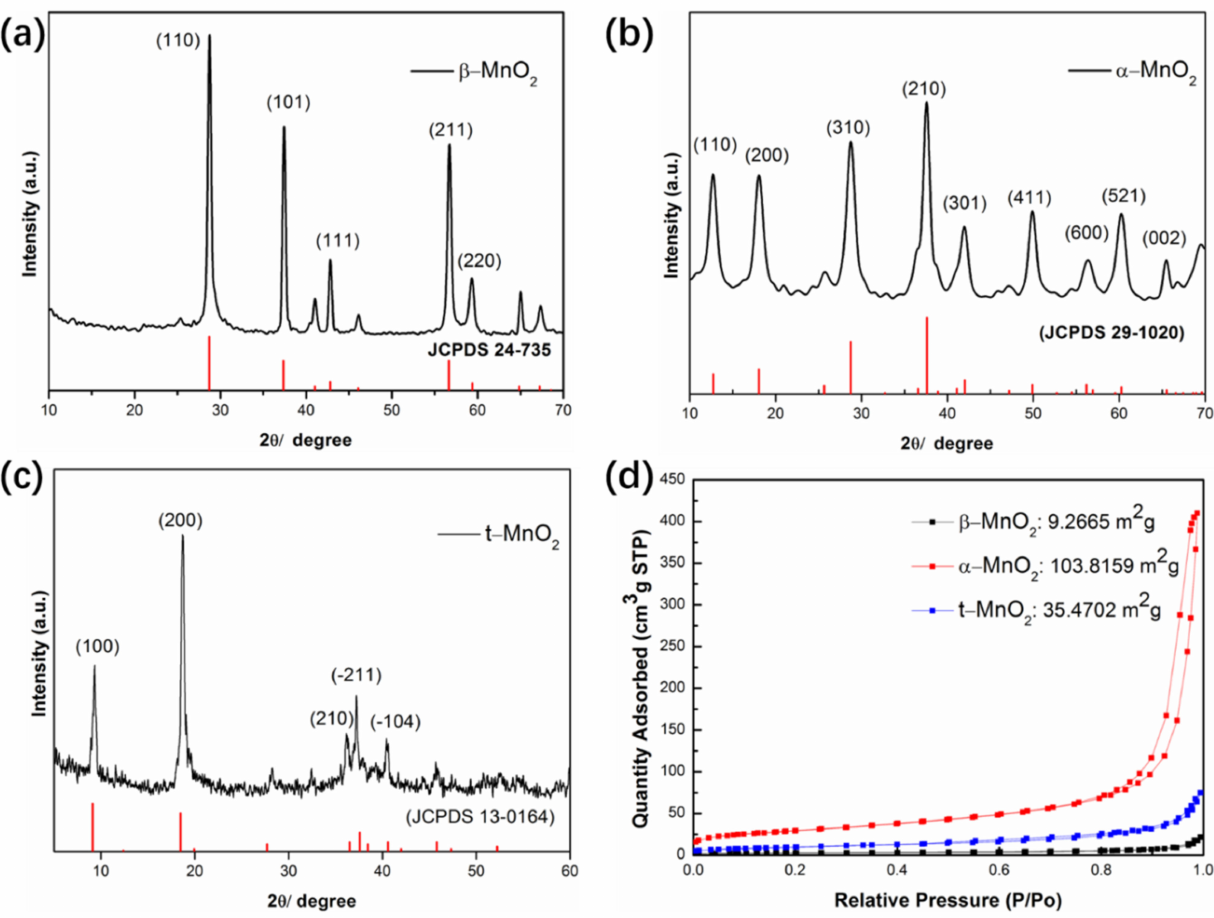
Figure 3. Material characterization: ( a ) XRD pattern of the β -MnO 2 ; ( b ) XRD pattern of α -MnO 2 ; ( c ) XRD pattern of t-MnO 2 ; ( d ) Nitrogen adsorption-desorption isotherm of the synthesized MnO 2